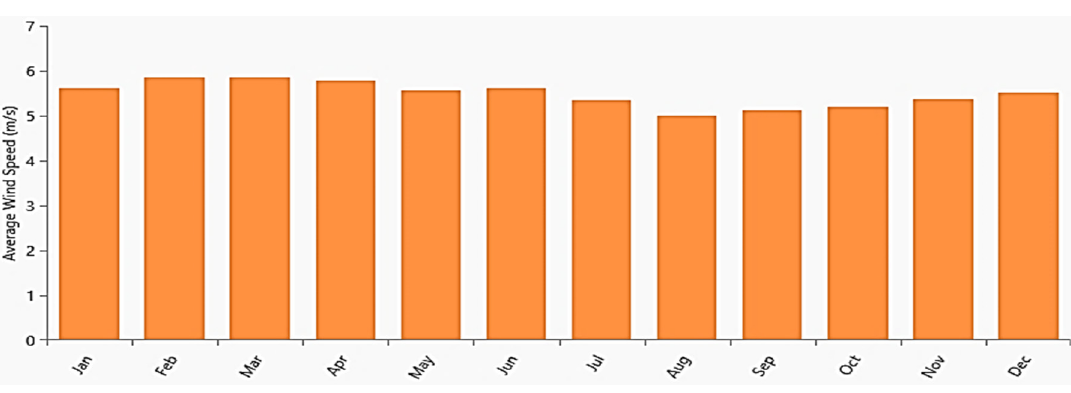
Figure 6. Monthly average wind speed data, Zagazig based on the input data from [24].